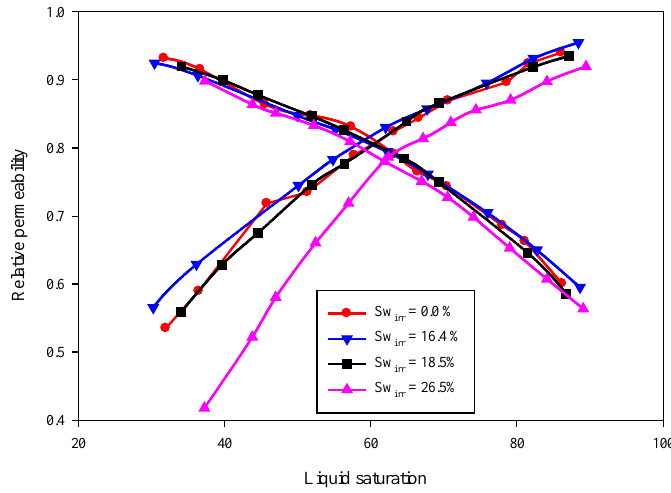
ff ect of irreducible water saturation on two-phase gas / oil-relative permeability Figure 6. Effect of irreducible water saturation on two-phase gas/oil-relative permeability [91]. Figure 6. E